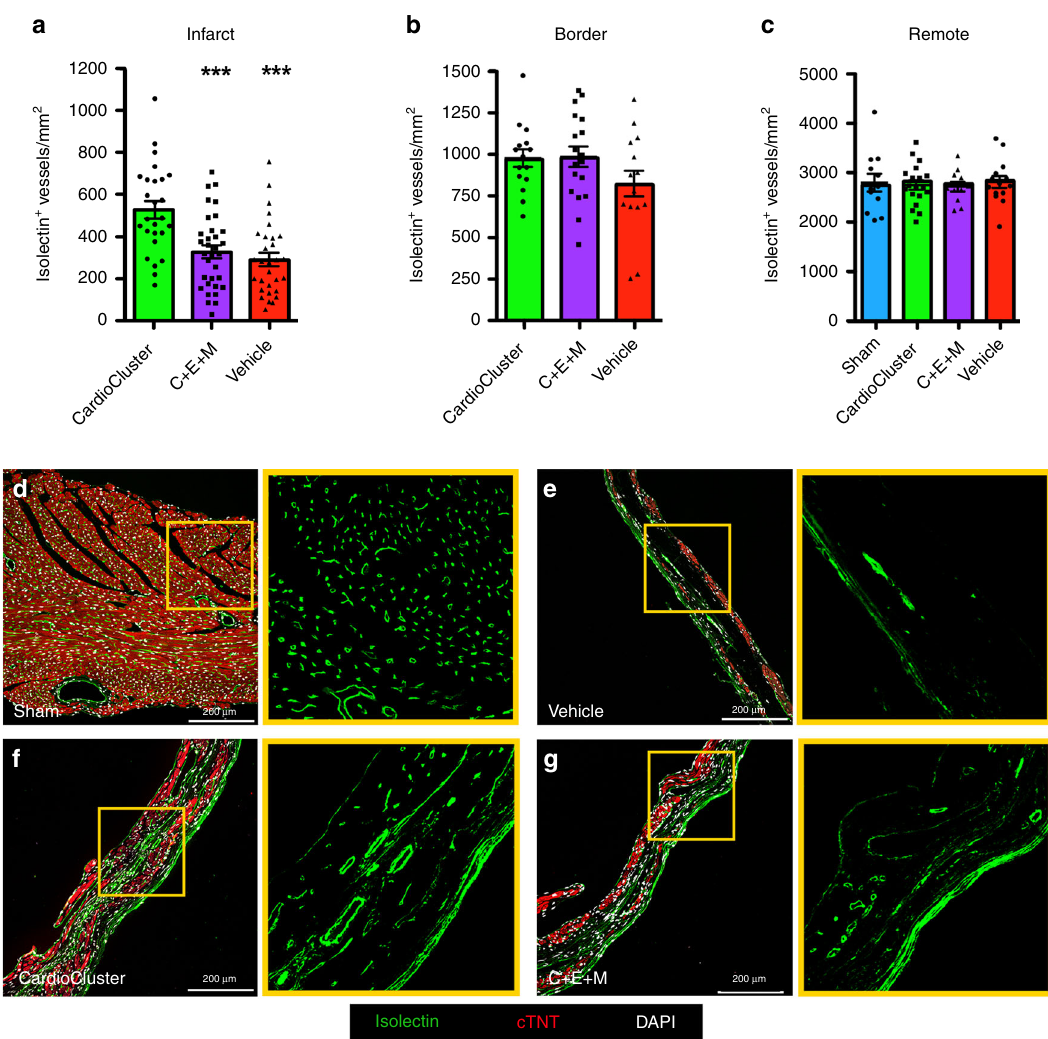
Fig. 7 CardioCluster treatment increases capillary density in the infarct region. a – c Quantitative analysis represents measurement of capillary density in the infarct ( a ), border zone ( b ), and remote ( c ) heart regions. Data represents mean ( n = 5 CardioCluster-treated mice; n = 6 C + E + M-treated mice; n = 5 vehicle-treated mice; n = 4 sham mice) ± SEM. Data are presented as one-way ANOVA with Tukey ’ s multiple comparisons test, *** p < 0.001, CardioCluster versus vehicle. *** p < 0.001, CardioCluster versus C + E + M. d – g Representative image of isolectin + vessels in sham ( d ) and infarct regions of Vehicle ( e ), CardioCluster ( f ), and C + E + M ( g ) used to quantitate capillaries (isolectin B4; green), cardiac troponin T (cTNT; red), and nuclei (DAPI; white). Right panels show higher magni fi cation of isolectin + vessels from areas highlighted by yellow boxes. Scale bars, 200 μ m. Source data are provided as a Source data fi